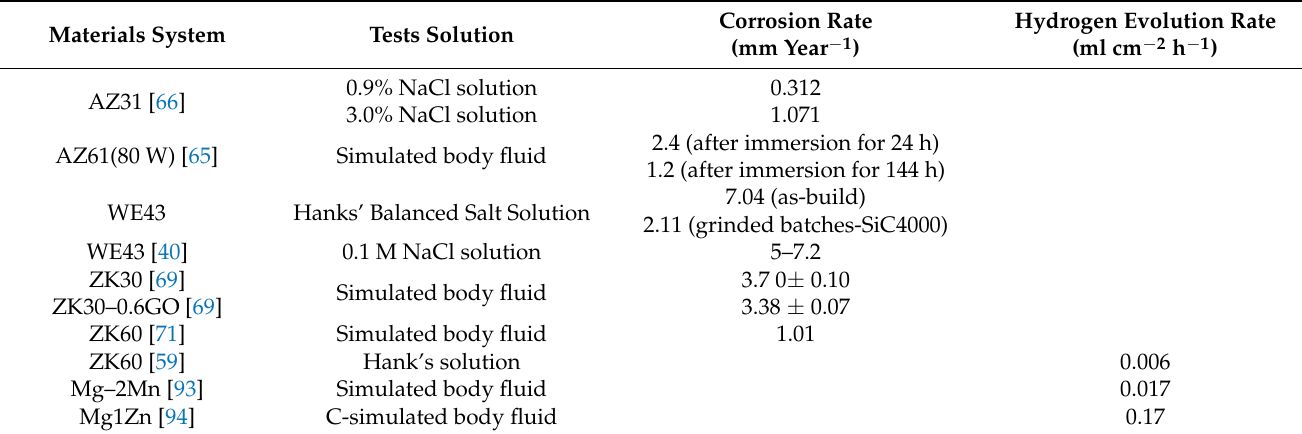
Table 3. Summary of corrosion rate of different Mg